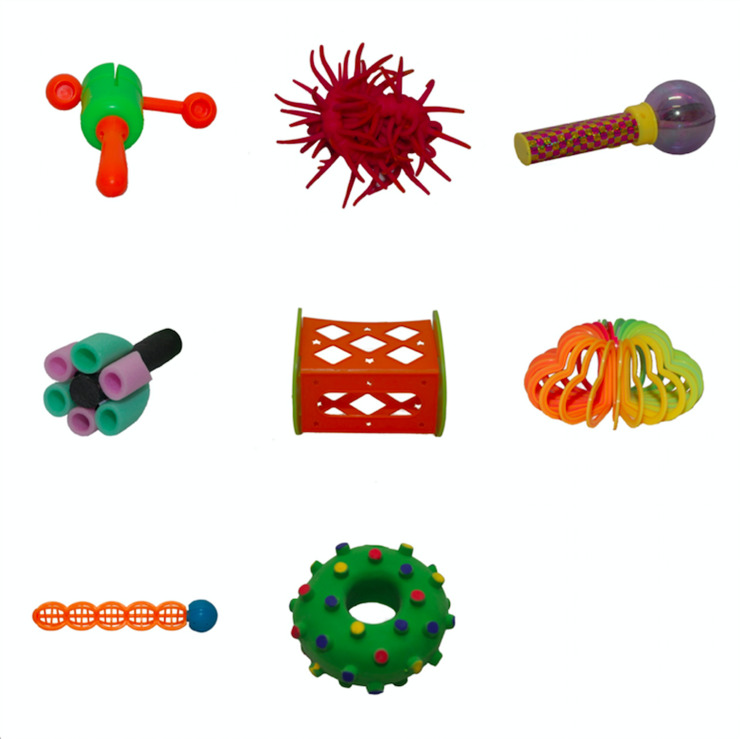
Novel objects (taken from [41]).